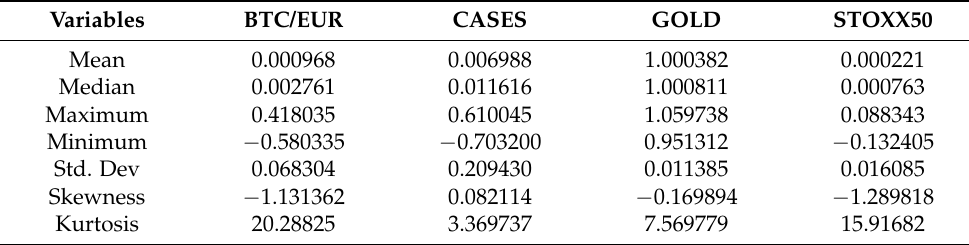
Table 1. Descriptive statistics.